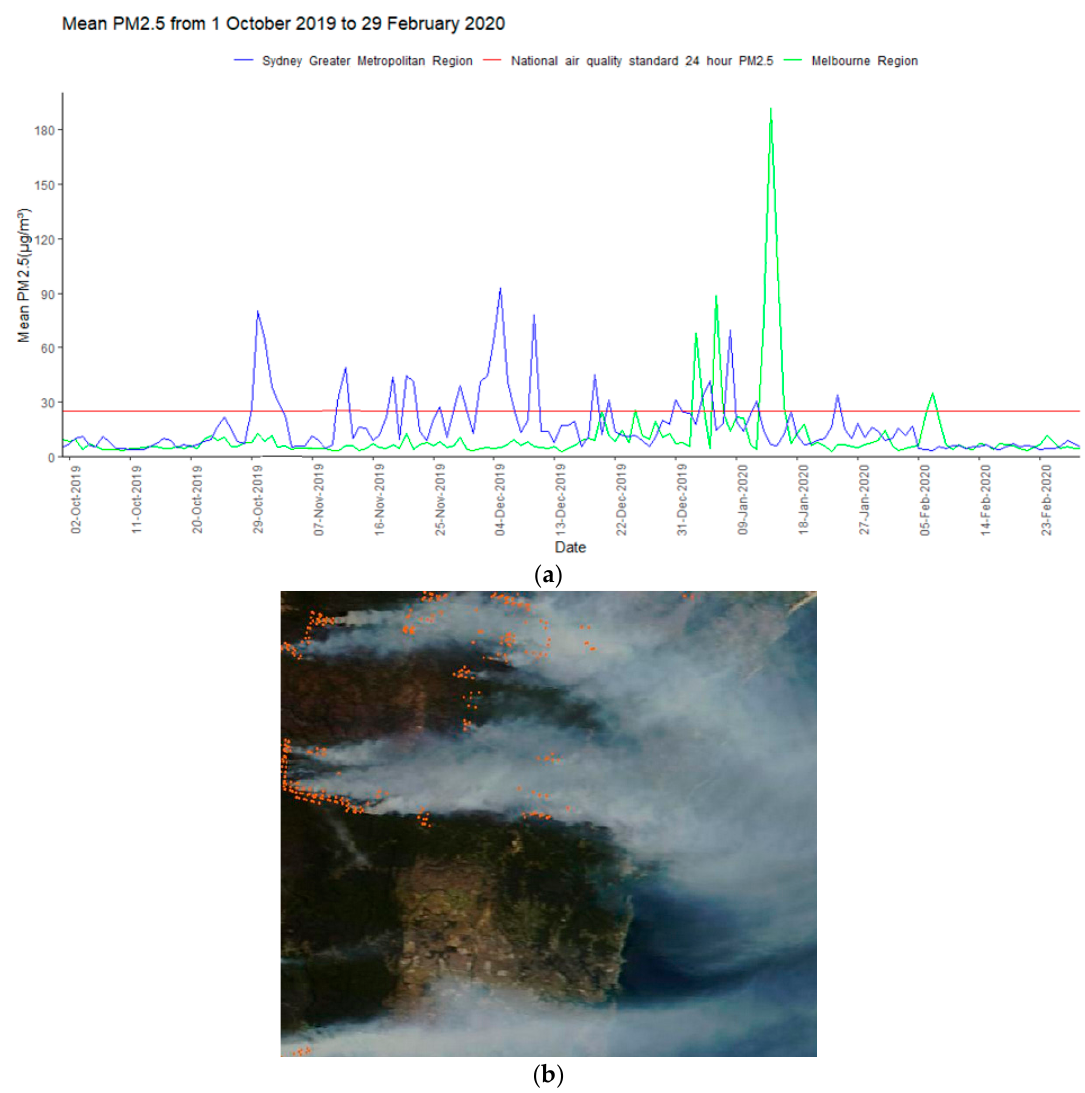
Figure 2. Bushfire smoke exposure during the 2019/2020 bushfire period. Participant exposure was assessed using PM 2.5 measures from fixed site monitors and geolocated for participant address (Panel ( a )). Confirmation of bushfire activity was obtained from images as seen by the Moderate Resolution Imaging Spectroradiometer Terra satellite (exemplar image shown in Panel ( b )). Bushfire exposure days were identified using a method validated for Australian settings based on data from panels ( a , b ) using high level PM 2.5 exposure together with satellite image confirmation of bushfire activity. ( a ) Population-weighted mean daily PM 2.5 concentration in the Sydney Greater Metropolitan Region (New South Wales) and Melbourne Region (Victoria) during the 2019/2020 bushfire period (1 October 2019 to 29 February 2020); ( b ) Fire hot spots and smoke plumes in the Sydney region, as seen by the Moderate Resolution Imaging Spectroradiometer Terra satellite on 4 December 2019. The orange spots indicate fires.